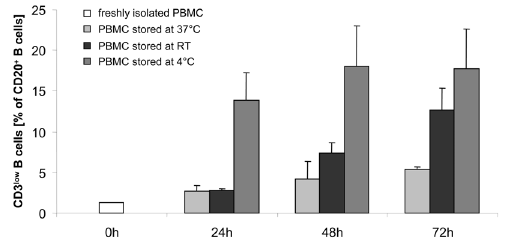
Figure 6. Numbers of CD3 low CD20 + B cells are time- and temperature-dependent. The increase in the number of CD3 low CD20 + B cells was time-dependent, but independent of storage conditions (4 u C versus room temperature (RT) versus humidified atmosphere at 37 u C, 5% CO 2 ). CD3 low CD20 + B cells were detectable at earlier time points and more pronounced at 4 u C storage compared to RT and 37 u C incubation, respectively. Shown are the results of two independent experiments performed in the same patient.